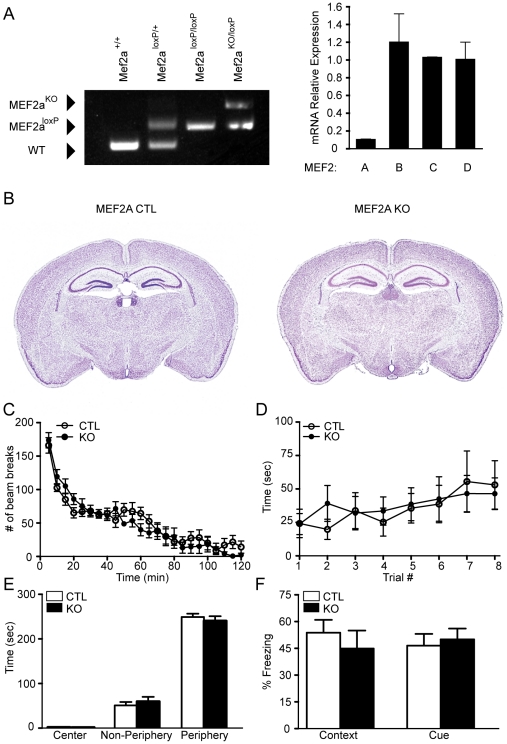
Mef2aKO mice show normal behavior.(A) Left, PCR genotyping to distinguish different Mef2a alleles. Right, the bar graph shows expression levels of Mef2 isoforms in the hippocampus of 4 week old animals (n=3/genotype), detected by quantitative PCR. The fold change in RNA was calculated using the comparative Ct method, normalizing to GAPDH as a control. (B) Nissl staining of brain cross-sections from littermate control (CTL) and Mef2a
KO mice at 2 months of age. Brain-specific deletion of MEF2A was achieved by crossing MEF2AloxP/loxP mice with mice harboring a transgene for hGFAP-Cre. (C) Mef2aKO (KO) mice show no significant differences in locomotor activity compared to littermate CTL mice as assessed by consecutive beam breaks over a two-hour period, although the number of beam breaks significantly decreased over time (F23,184=41.84, P<0.0001), there was no significant interaction between group and time (CTL, n=8; Mef2aKO mice, n=9). (D) Mef2aKO mice have no difference in motor coordination as assessed in the rotarod test compared to littermate CTL mice (CTL, n=8; Mef2aKO mice, n=9). (E) Mef2aKO mice exhibit normal anxiety-like behavior, as assessed in the open field test (CTL, n=8; Mef2aKO mice, n=9). (F) Context- and cue-dependent fear conditioning is unaltered in Mef2aKO mice relative to littermate CTL mice (CTL, n=8; Mef2aKO mice, n=9). All data is shown as mean ± SEM.